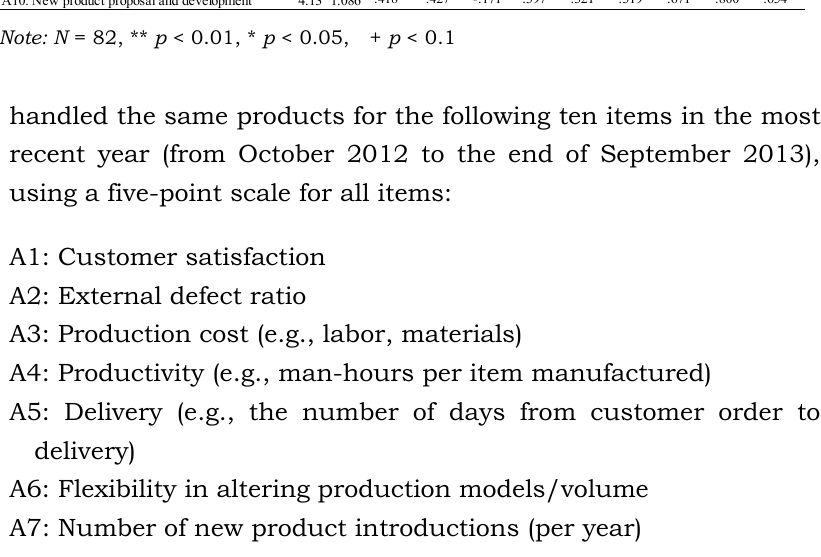
Note: N = 82, ** p < 0.01, * p < 0.05, + p <